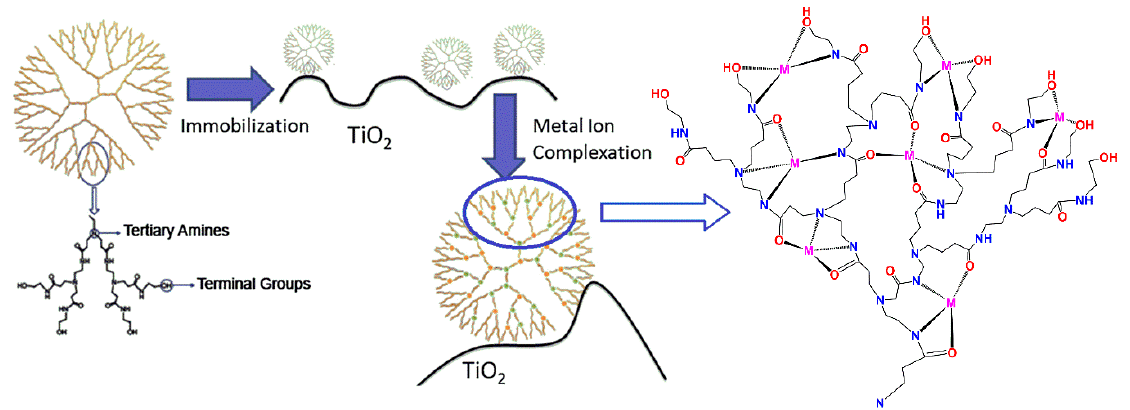
Figure 4. Schematic representation of the immobilization process of G4 dendrimers onto the surface of titania. (Reproduced with permission from [67]; Copyright Elsevier, 2013).